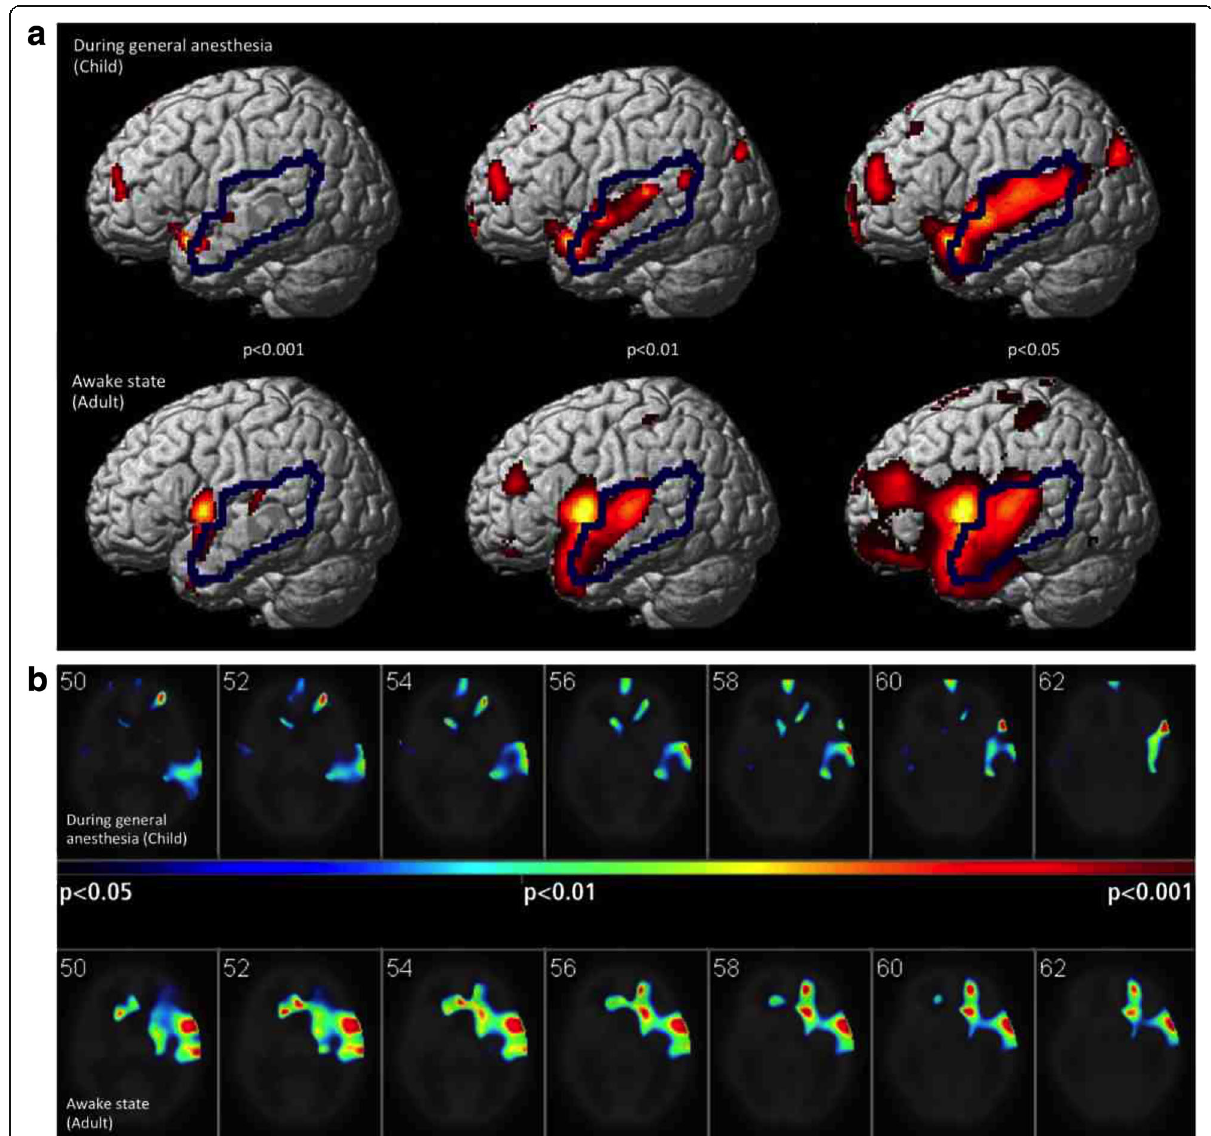
Fig. 1 a Examples of activations in auditory and extra-auditory regions (AR and eAR separated by blue line), during general anesthesia in a child and awake state in an adult patient detected with different cut-off levels used for statistical inferences (all smoothed with a filter kernel of [20 mm] 3 ). Stimulation was done via cochlear implant (upper row) and promontory needle electrode (lower row), respectively. Note: A realistic size of activations in AR during narcosis was only achieved using the cut-off levels of p <0.01 or p <0.05. At the same time, relatively less activation in eAR is seen during anesthesia compared to waking state with these cut-off levels. b Corresponding t-maps to the examples displayed below a . The t-map from the study acquired during general anesthesia in a child nicely depicts the activated auditory cortices with p <0.01 (color scale green/blue), while the t-map reflecting the waking state study in an adult patient did the same with p <0.001 (color scale dark red/brown). Using p <0.01 for the latter would result into pseudo-activation up